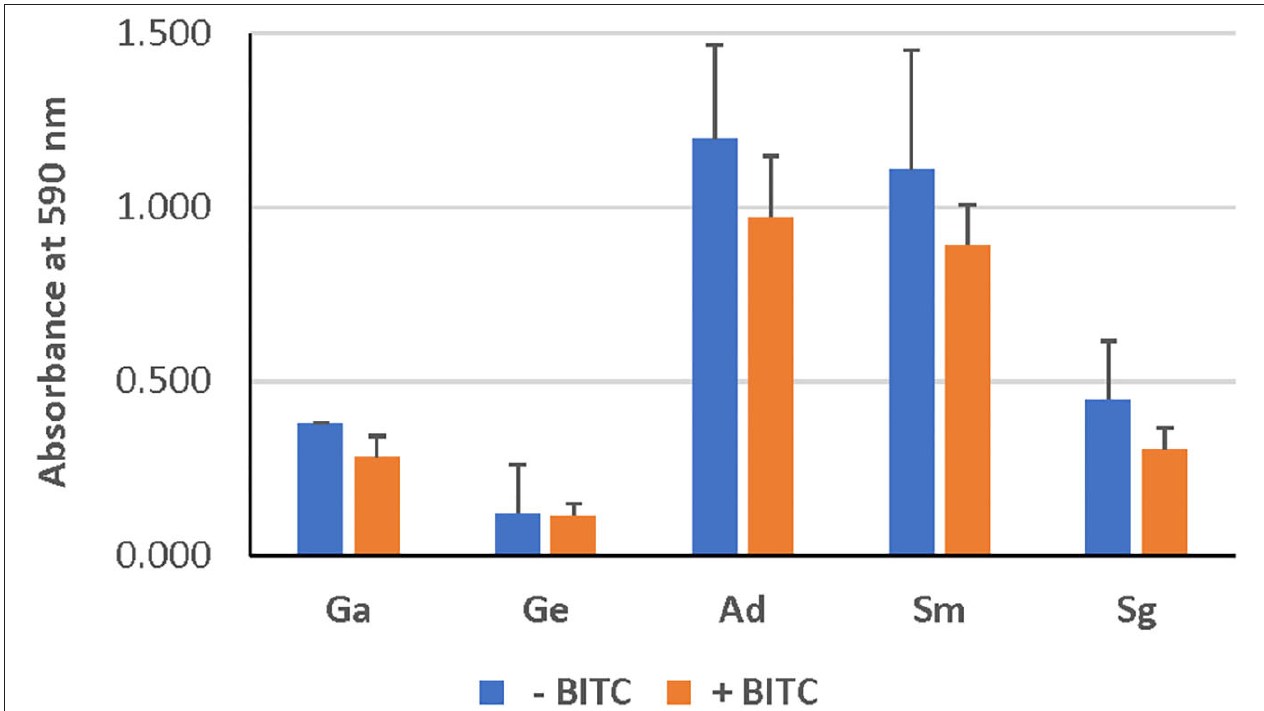
FIGURE 3 | Effect of BITC treatment on the biofilms. The biofilm biomass was quantified by crystal violet staining after treating with BITC for 2h in 5% CO 2 at 37 ◦ C. The absorbance was measured at 590nm wavelength. Ga, G. adiacens ; Ge, G. elegans ; Ad, A. defectiva ; Sm, S. mutans ; Sg, S. gordonii